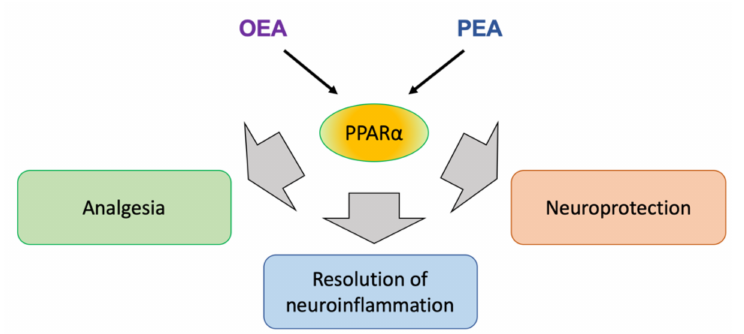
Figure 3. Endocannabinoids OEA and PEA exert analgesic, anti-inflammatory, and neuroprotective actions through PPAR α activation. A detailed explanation is provided in the